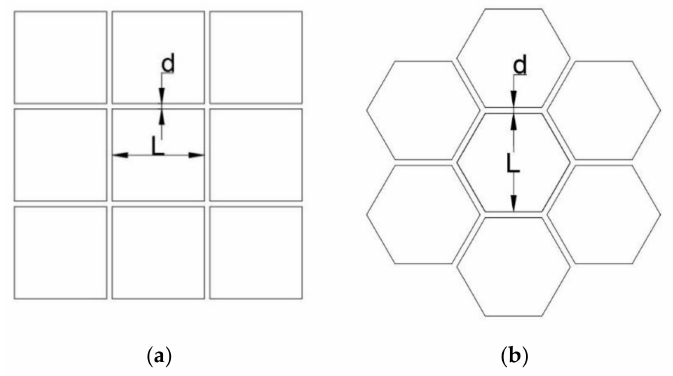
Figure 2. ( a ) Square cell array, ( b ) hexagonal cell array.